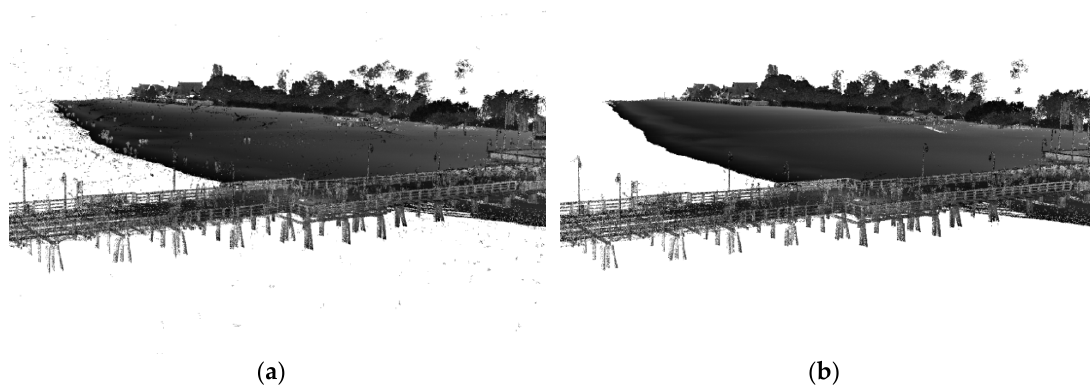
Figure 9. 3D point clouds obtained from the terrestrial laser scanning (TLS) containing measurement noise ( a ) and after their removal ( b ).